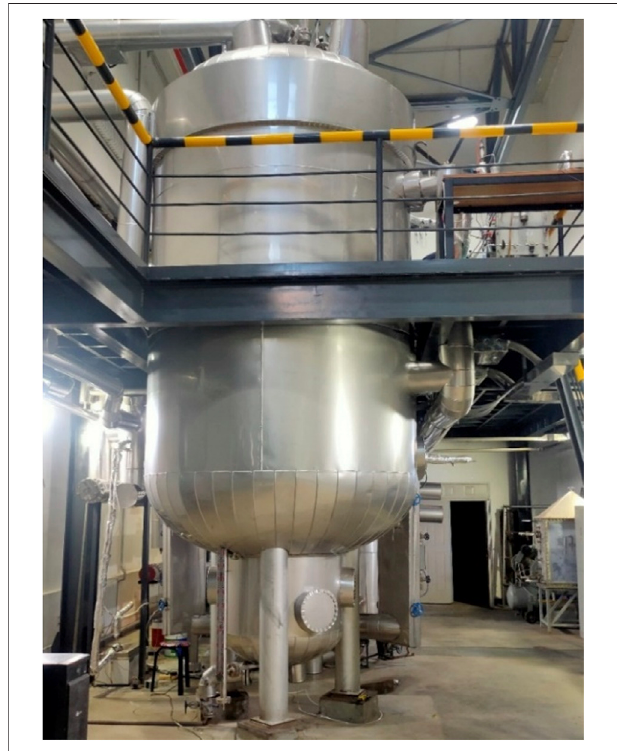
FIGURE 1 | Vessel of the COSTTHES